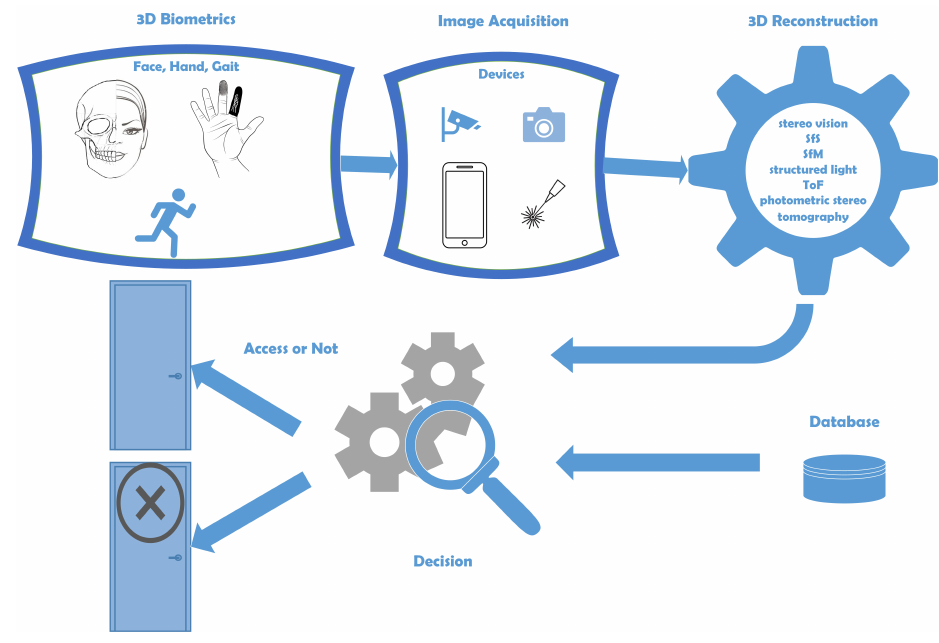
Figure 7. Three-Dimensional (3D) Biometrics General